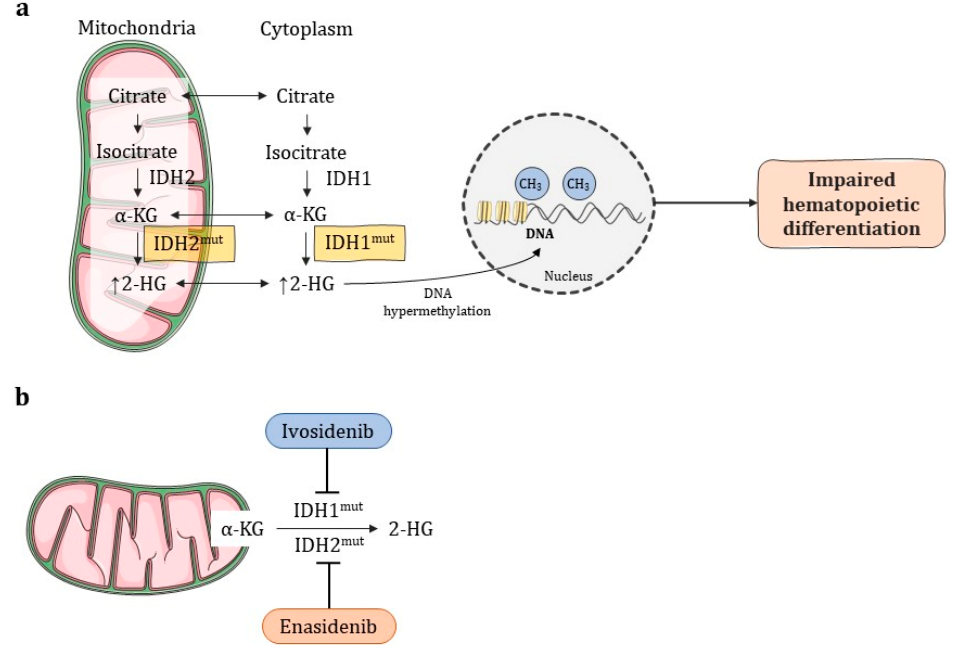
Figure 8. Ivosidenib and Enasidenib mechanism through mitochondrial citrate metabolism. Muta- tions in IDH1 and IDH2 enzymes drive accumulation of the 2-HG citrate metabolite, causing DNA hypermethylation and impaired hematopoietic differentiation ( a ). Enasidenib and Ivosidenib act on mutated IDH1mut and IDH2mut, restoring 2-HG citrate metabolite levels and returning cell metabolism to differentiation and sensitiveness to cell death ( b ).